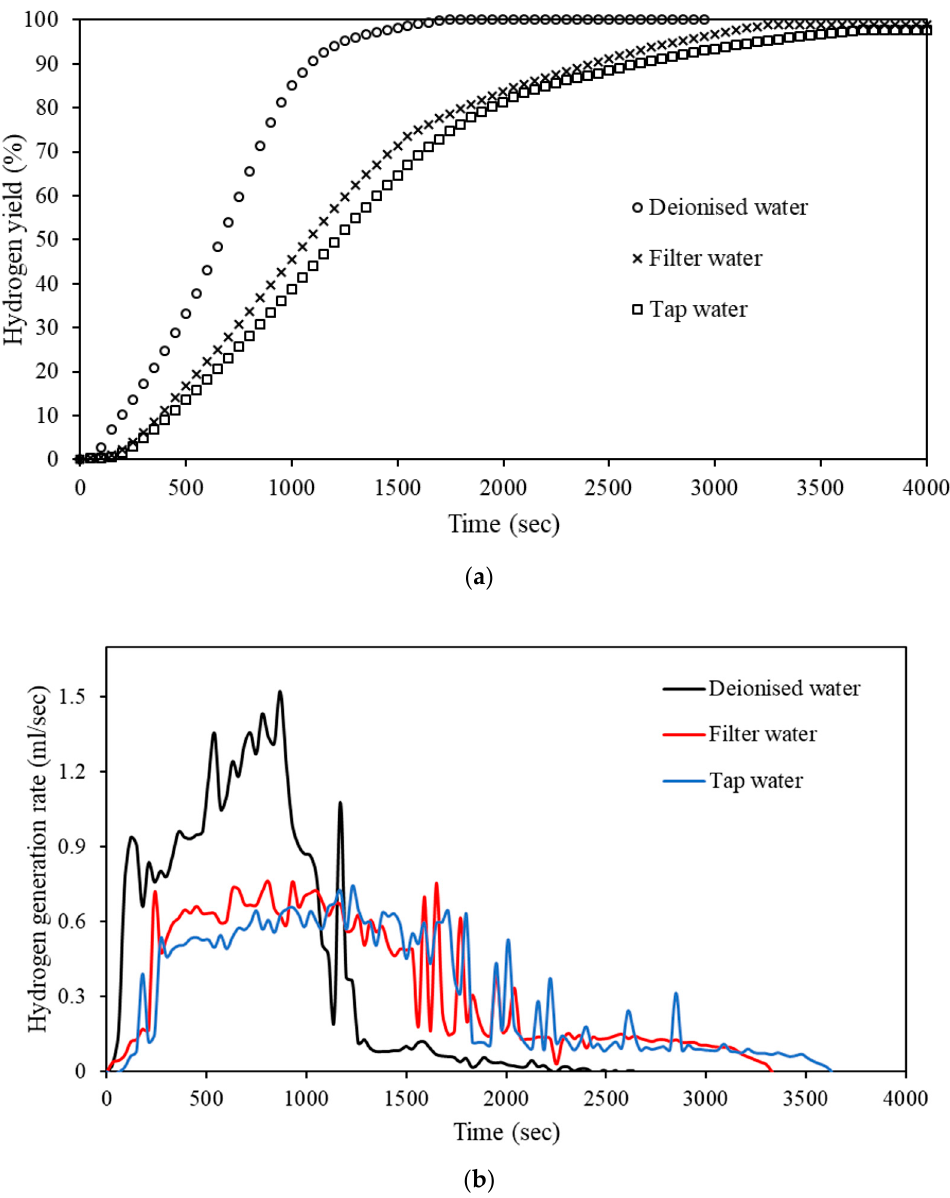
Figure 7. Hydrogen yield curves ( a ) and hydrogen generation rates ( b ) of Al-9.25% Bi-0.75% Ni hydrolyzed using different water qualities.